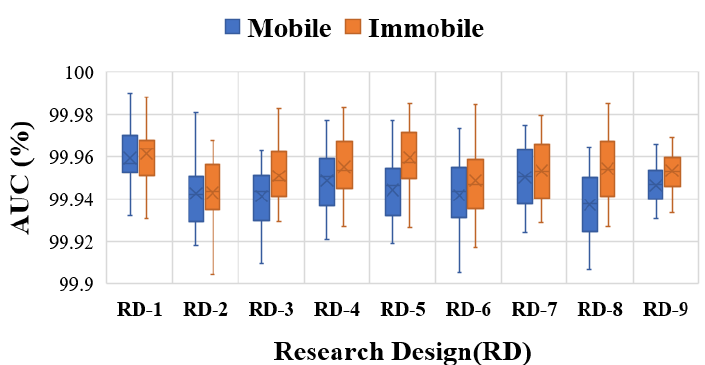
Figure 10. Area Under Curve observed during ROC curve analysis of UCIHAR data to determine operational points of two abstract concepts (i.e., Mobile and Immobile ) for all nine Research Designs